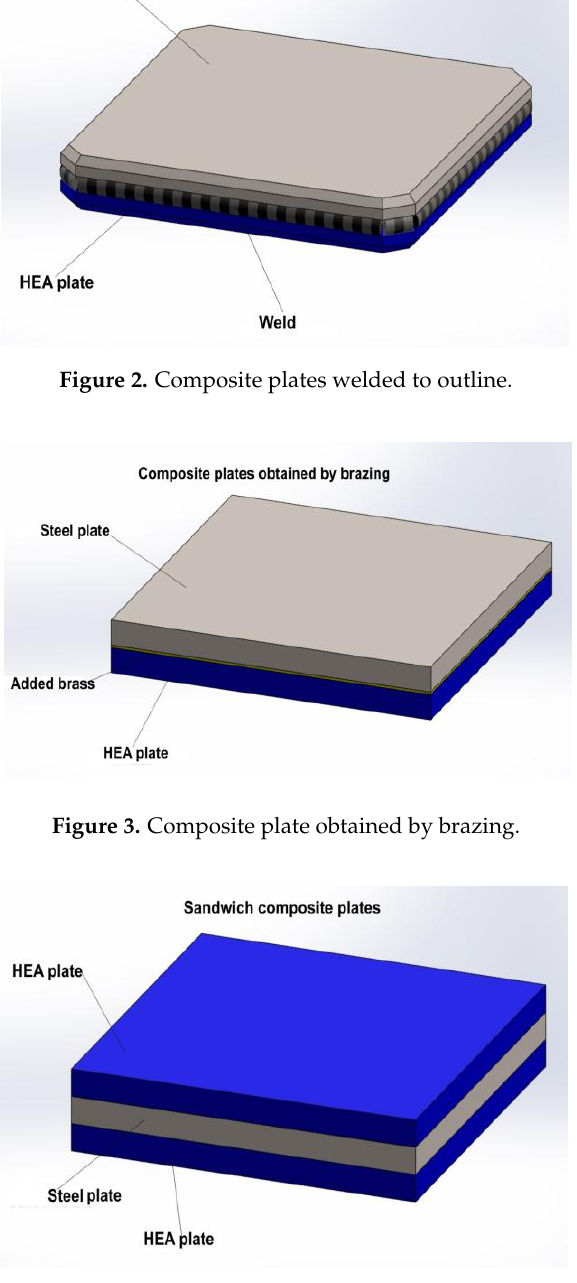
Figure 4. Sandwich composite plates.